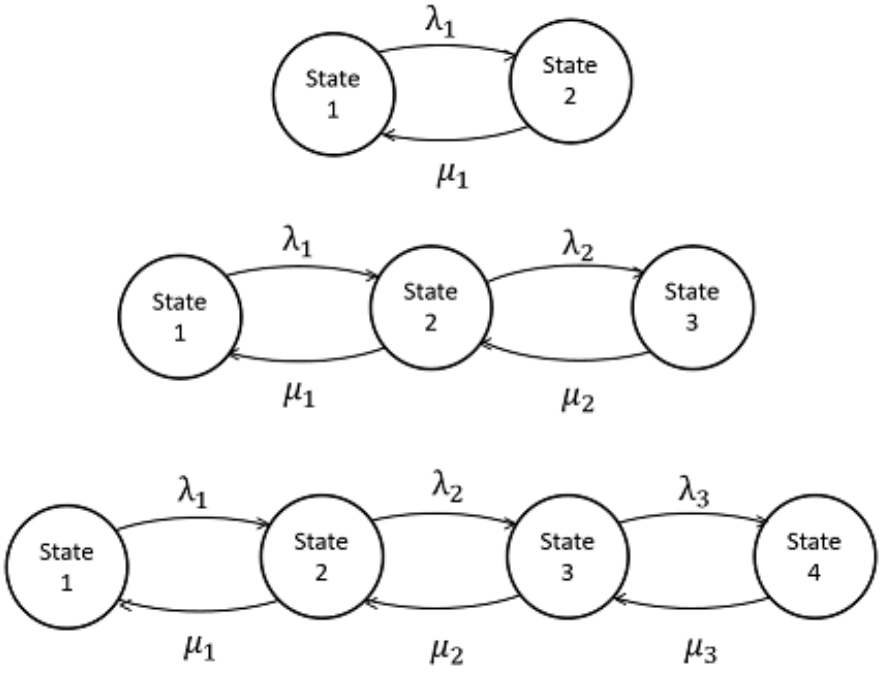
Figure 9. Case study 2: The Markov graph for each component in the MSS.